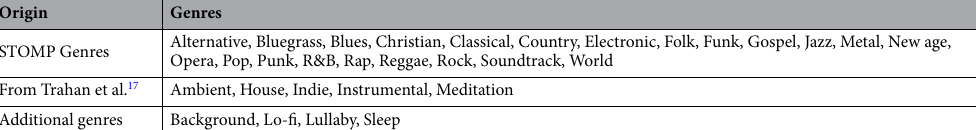
Table 2. All main genres used to reduce the genre